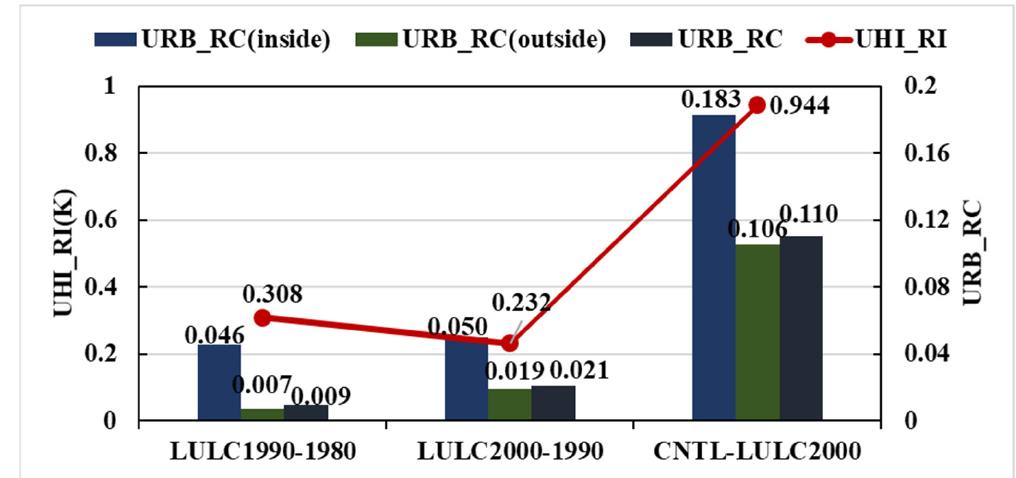
Figure 7. The response intensity of UHI and the changes in the urbanization ratio over every decade. The UHI_RI (Unit: K) was the UHII changes of two cases, and the URB_RC (inside), URB_RC (outside), and URB_RC represent the changes in the urbanization ratio of the region inside the third ring road, outside the third ring road, and the whole region of Wuhan, respectively.